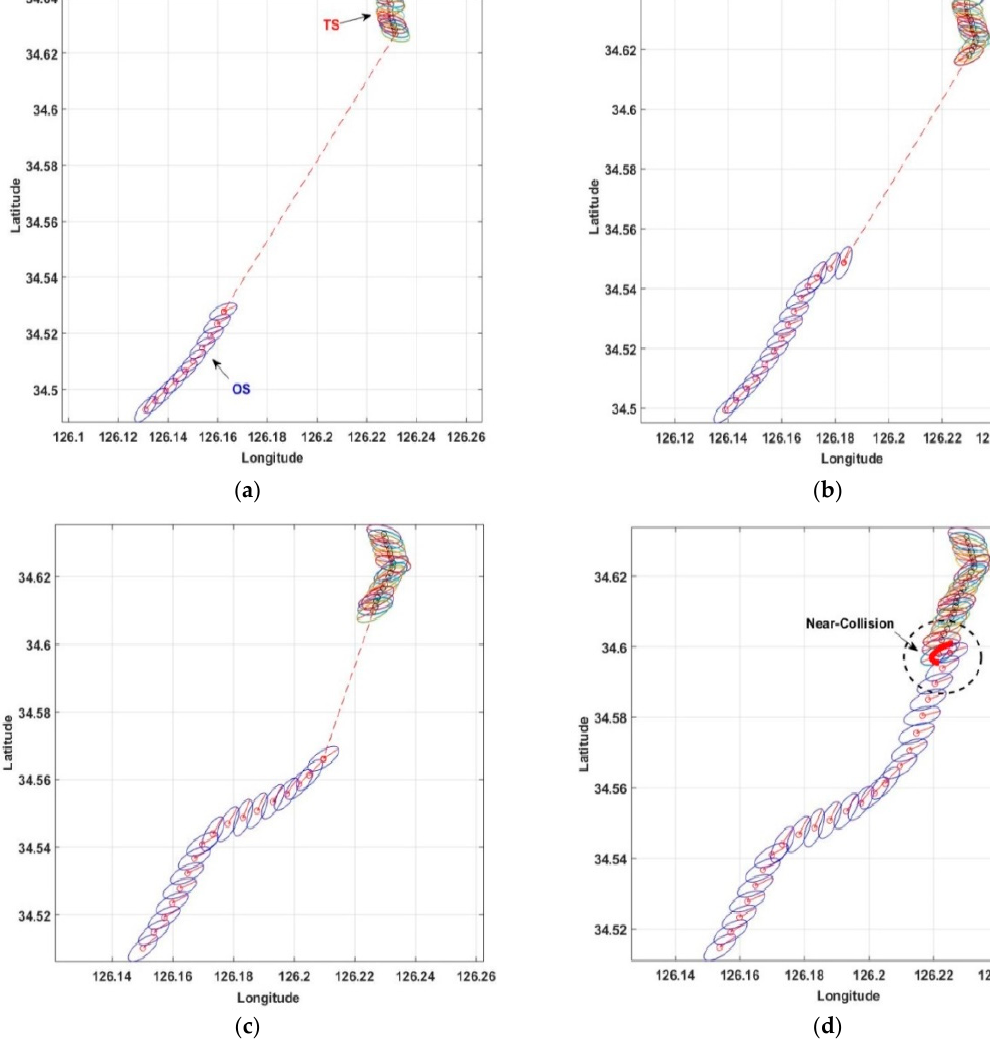
Figure 14. Encounter situation between the OS and the TS: ( a ) head-on situation at relative distance “6.86 nm”; ( b ) head-on situation at relative distance “4.75 nm”; ( c ) head-on situation at relative distance “2.74 nm”, and ( d ) near-collision at relative distance “0.75 nm”. The FOU size “ ± 0%, ± 5%, ± 10%, ± 15%, ± 20%, and ± 50%” were measured by the linear R c as shown in Figure 15 and Table 4. On the other hand, the FOU size “ ± 25%, ± 30%, ± 35%, ± 40%, and ± 45%” were measured by the non-linear R c as presented in Figure 16 and Table 5. At the initial encounter situation between the OS and the TS, the FOU size “ ± 0%, ± 5%, ± 10%, ± 15%, ± 20%, and ± 50%” inferred the R c 0.00, 0.01, 0.01, 0.00, 0.00, and 0.16, respectively. The FOU size “ ± 25%, ± 30%, ± 35%, ± 40%, and ± 45%” inferred the R c 0.00. When it comes to a point of time for a give-away vessel (i.e., R c 0.33), the computed linear R c based on the FOU size “ ± 0%, ± 5%, ± 10%, ± 15%, ± 20%, and ± 50%” gave the alarm at about 7.93 nm and 1800 s left until near-collision. The computed non-linear R c based on the FOU size “ ± 25%, ± 30%, ± 35%, ± 40%, and ± 45%” gave the alarm at about 7.93 nm and 1800 s, 7.57 nm and 1710 s, 7.57 nm and 1710 s, 6.86 nm and 1530 s, and 7.21 nm and 1620 s, respectively. In near-collision situation, the FOU size “ ± 0%, ± 5%, ± 10%, ± 15%, ± 20%, and ± 50%” computed the R c 0.99, 0.99, 0.99, 0.98, 0.98, and 0.97, respectively. The FOU size “ ± 25%, ± 30%, ± 35%, ± 40%, and ± 45%” computed the R c 0.98, 0.98, 0.98, 0.97, and 0.97,